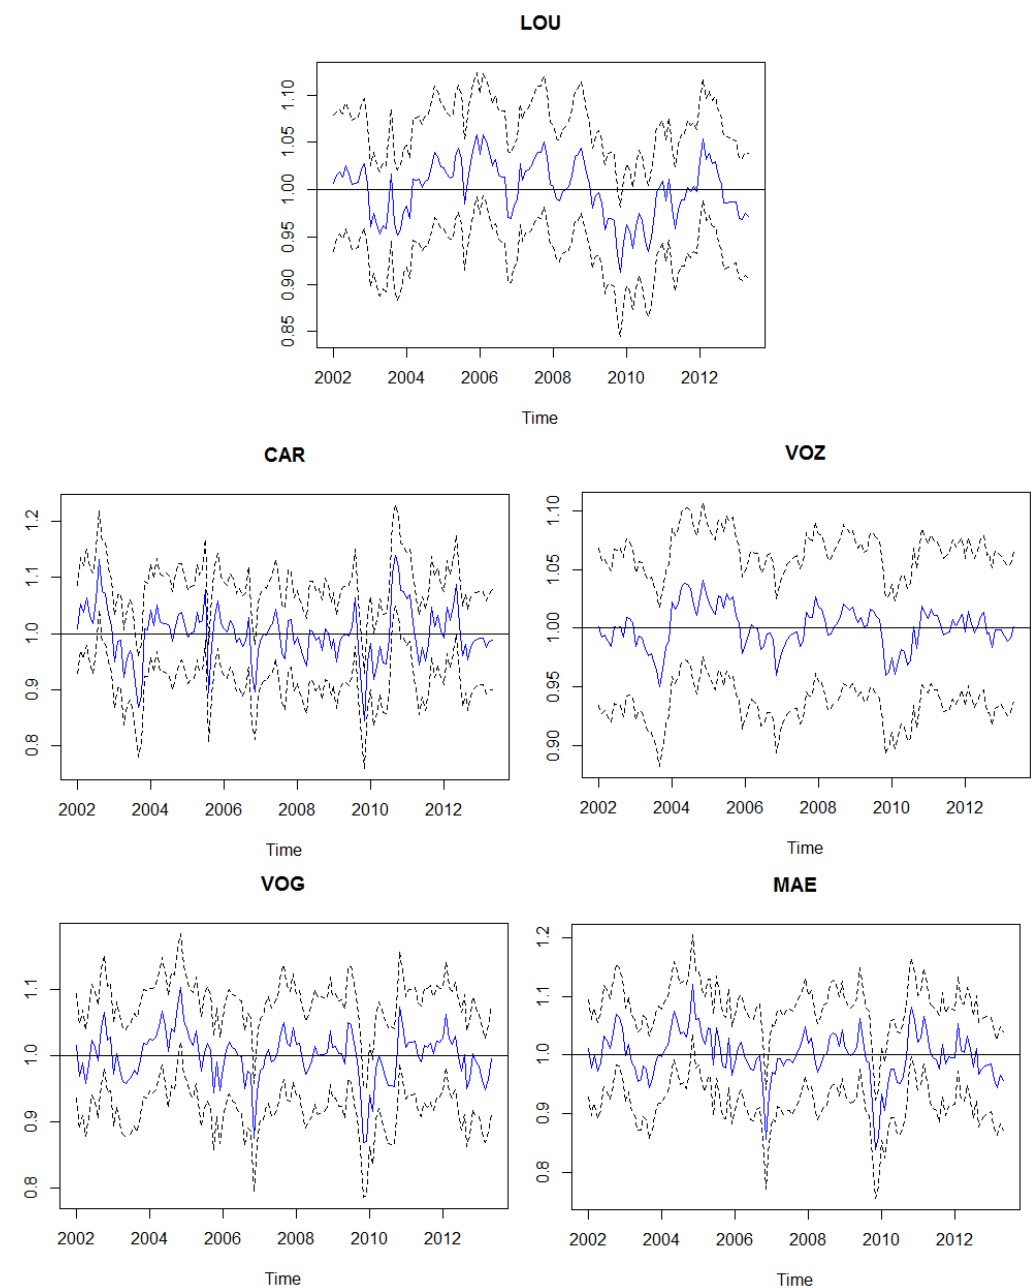
Figure 6. Filtered estimates of calibration factor (cid:98) X t | t for all site locations with 95% empirical confidence